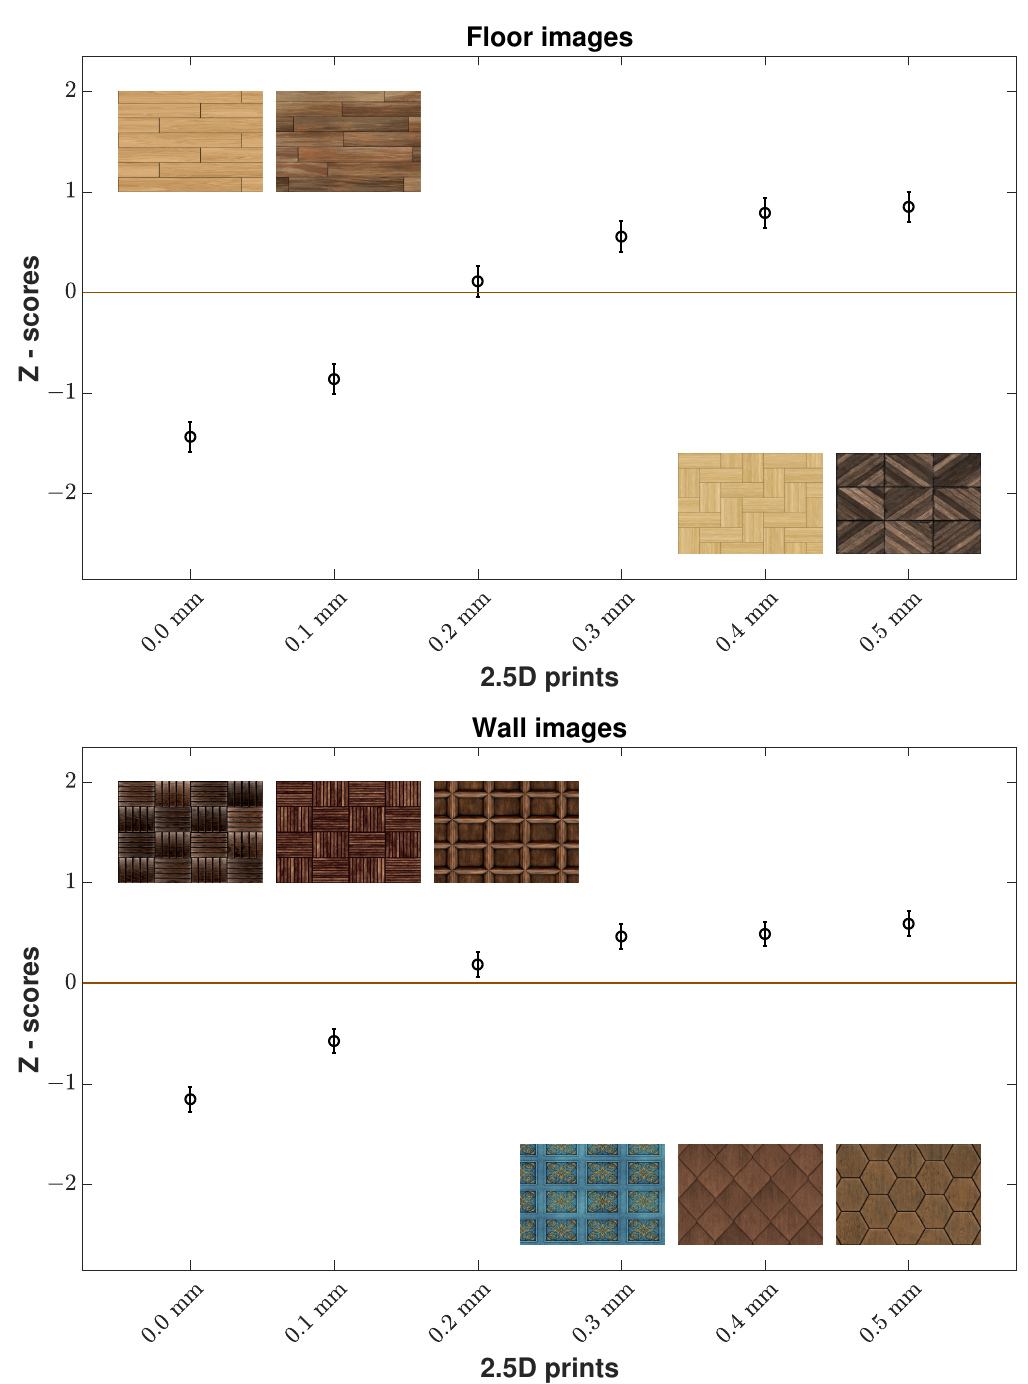
Figure 4. Z-scores of all wooden floor and all wooden wall images by all observers. Mean Z-score values for 2.5D prints at various elevation levels (x-axis) are given with 95% CI s. We can observe that for both floor and wall images, the observers found flat prints as the least natural. There are 4 floor and 6 wall